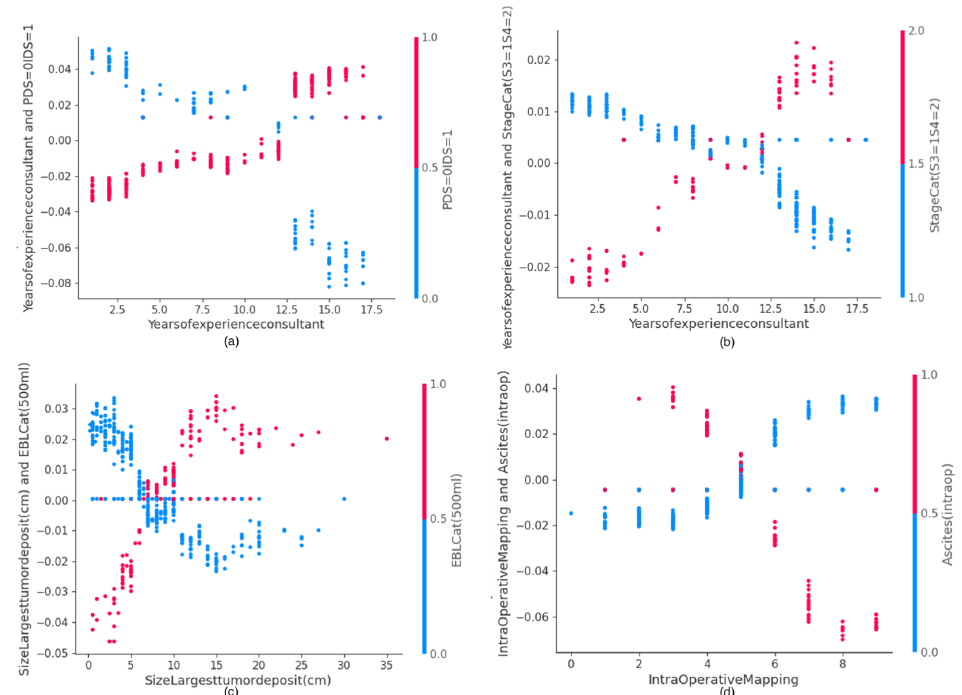
Figure 6. Examples of SHAP Value Interaction plots related to human factors: ( a ) Years of consultant experience and timing of surgery, ( b ) Years of consultant experience and stage, ( c ) Size of largest tumor and EBL, ( d ) Intra-Operative Mapping Score and ascites. EBL, Estimated Blood